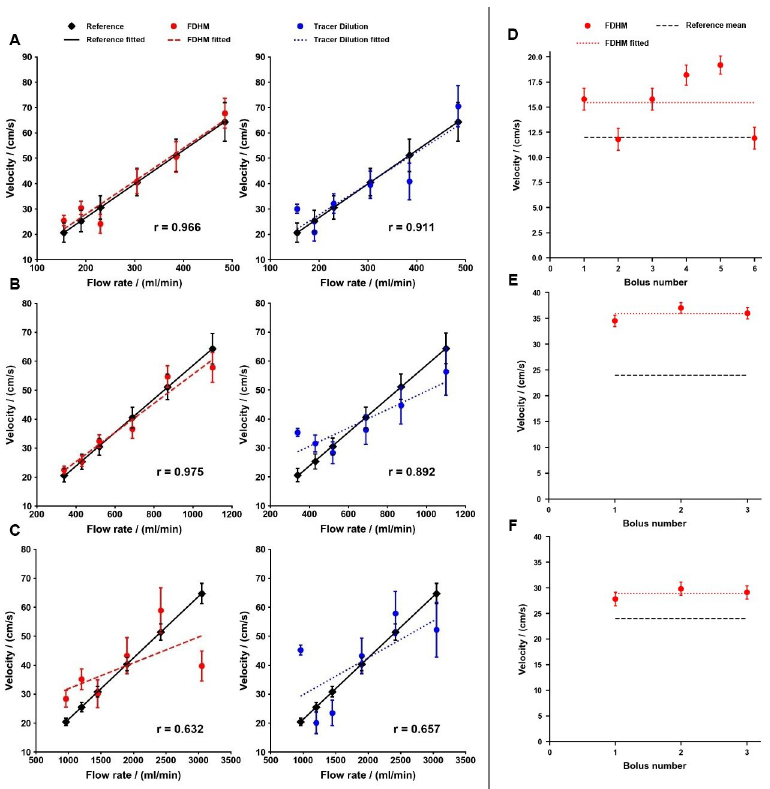
Fig 5. Computed velocities in comparison to the reference values of experiment A and B. Starting with experiment A, the first six plots show the velocities for the FDHM method and the tracer dilution method for glass tubes with an inner diameter of (A) 4 mm, (B) 6 mm and (C) 10 mm. The 4 mm diameter glass tube showed the best agreement for both algorithms, closely followed by the 6 mm diameter glass tube. The results were considerably inferior for the 10 mm diameter glass tube. The last three plots represent experiment B: Applying the correction factor of setting 2 on the measurements of setting 3 (D) and setting 4 (E) yields a mean relative error of 28% and 48% compared to the reference values, respectively. The lowest mean relative error of 20% is achieved when using the correction factor of setting 3 for setting 4 (F) . Error bars emerge from the error of the mean of the correction factors.